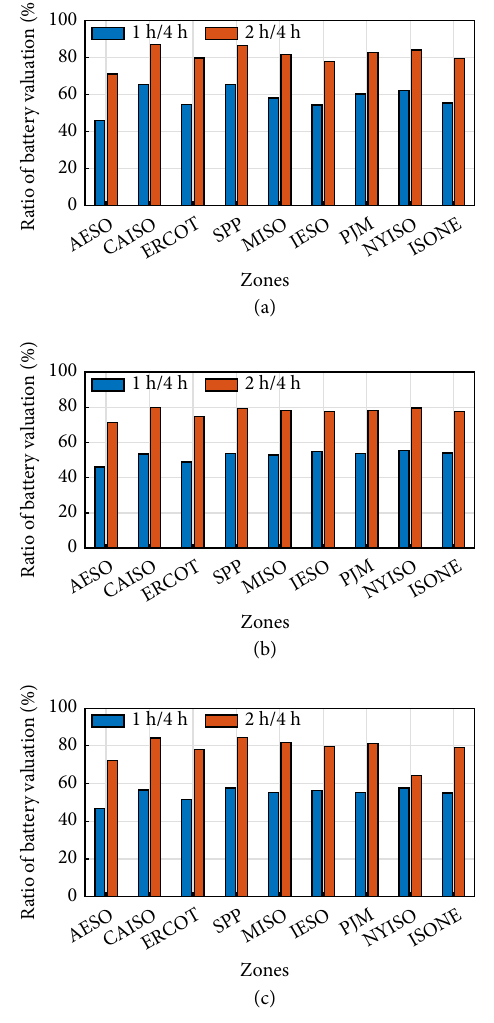
Fig. 5 Ratio of average battery valuations between hour duration for each technology for all zones (a) LFP, (b) NCA, and (c) NMC.